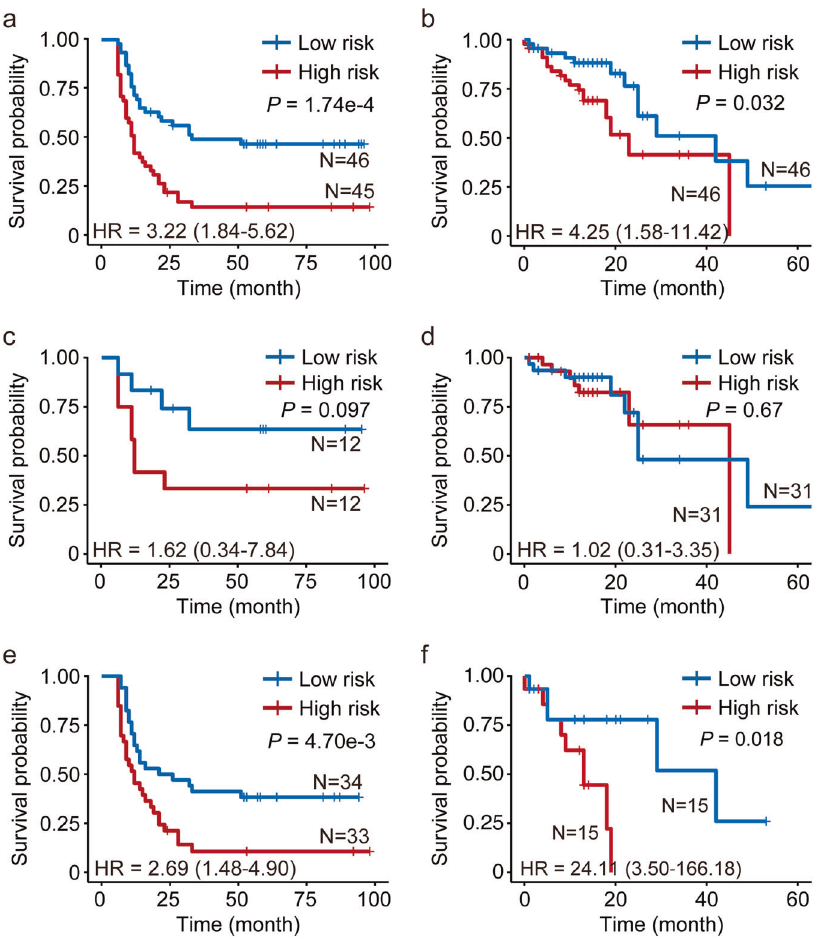
and in TCGA ESCC sample ( d ). e , f Kaplan – Meier survival curves for patients with advanced stage ESCC in our sample ( e ) and in TCGA ESCC sample ( f ). High- or low-risk group was de fi ned by the weighted hazard ratios of the 4 methylation sites in patients. The P value was calculated by log rank test. HR and 95% CI was computed with Cox hazard proportion